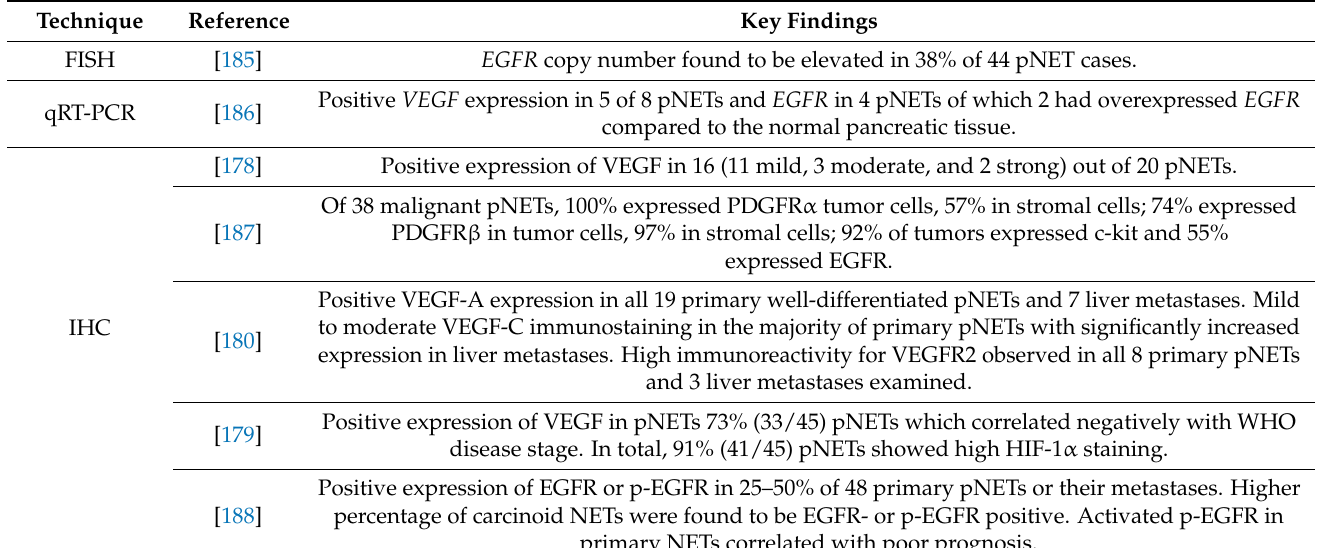
Table 7. Molecular profiling studies on growth factor signaling in